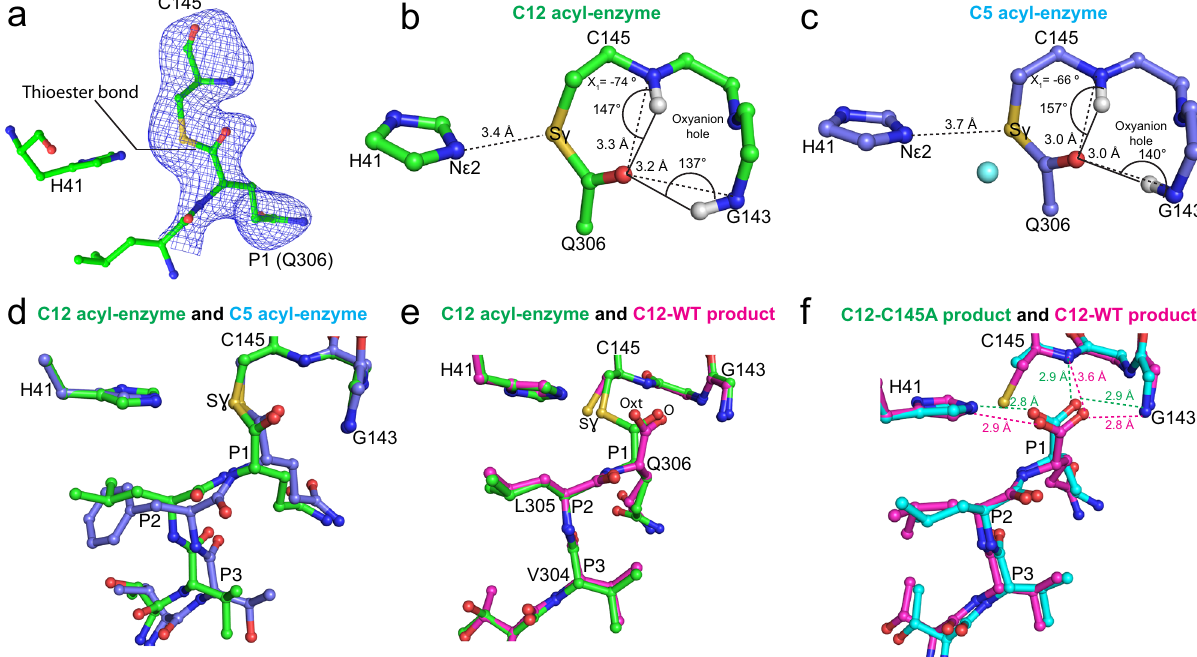
Fig. 6 | Characterization of wild-type M pro C12 acyl-enzyme complex structure and comparison to wild-type C12 product complex and C5 acyl-enzyme com- plex. a mF o -DF c omit electron density map (contoured at 3.0 σ , blue mesh) shows the thioester bond between the mainchain carbonyl carbon of Gln306 (chain C; residues Leu305 and Gln306shown) and the S γ of Cys145within the wildtypeM pro catalyticsite (chainB;His41and Cys145shown) of C12. The ball-and-stickstructure is shown with carbon green, nitrogen blue, sulfur gold, and oxygen red. b Analysis of the C12 acyl-enzyme structure (chains B and C). Ball-and-stick (carbon green, nitrogen blue, oxygen red, sulfur gold) view shows the geometry and atomic interactions of the thioester bond between the S γ of Cys145 and main chain car- bonylcarbonofGln306.Thetrigonalplanarthioestergroup,de fi nedbyatomsC α , C,andOofGln306,andS γ ofCys145isshownasisthe χ 1 dihedralangle(de fi nedby